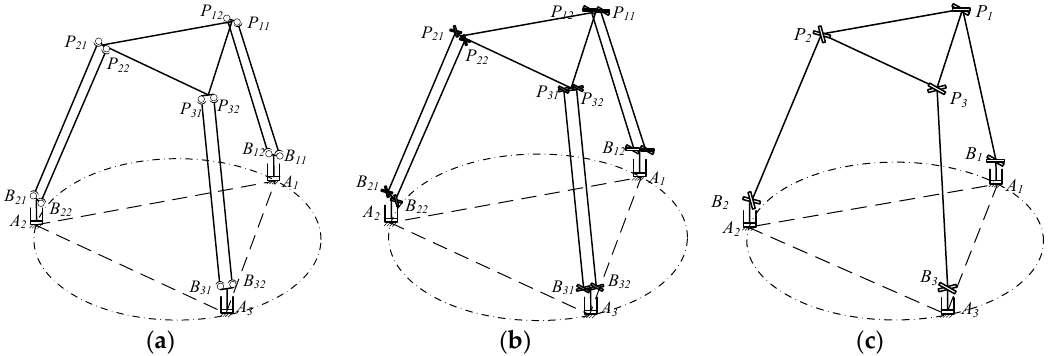
Figure 2. The equivalent process of the motion diagram. ( a ) Motion diagram. ( b ) PRB model. ( c ) Simplified PRB model.